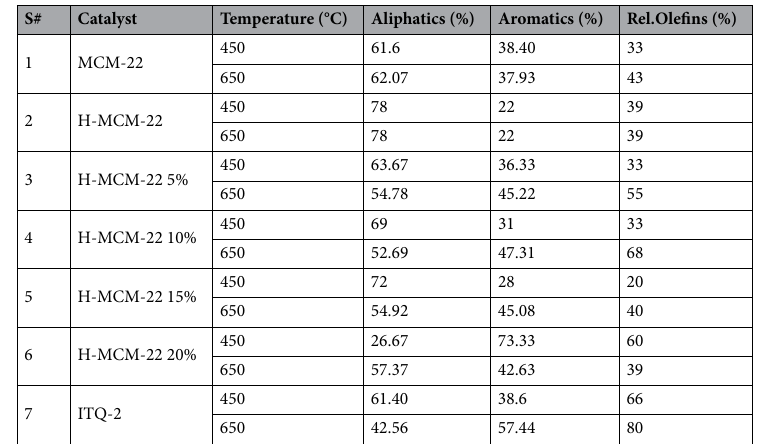
MCM-22 catalyst, along with its derivative structures, showed comparable results for n-hexane cracking. Almost every catalyst showed higher selectivity in transformation of alkanes into olefins at higher tempera- tures. H-MCM-22 10% provided the highest olefins concentration (68%) among de-aluminated H-MCM-22 zeolites owing to the efficient removal of acid amounts that suppress the hydride transfer for secondary reactions.